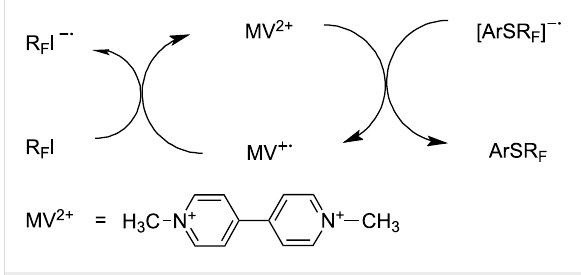
For diaryl disulfides the CF 3 • radical can attack either the sulfur atom or the aromatic ring, [132,210] and thus give rise to unde- sired side products. Arylperfluoroalkyl sulfides are formed also in a reverse strategy from aliphatic disulfides and aryl